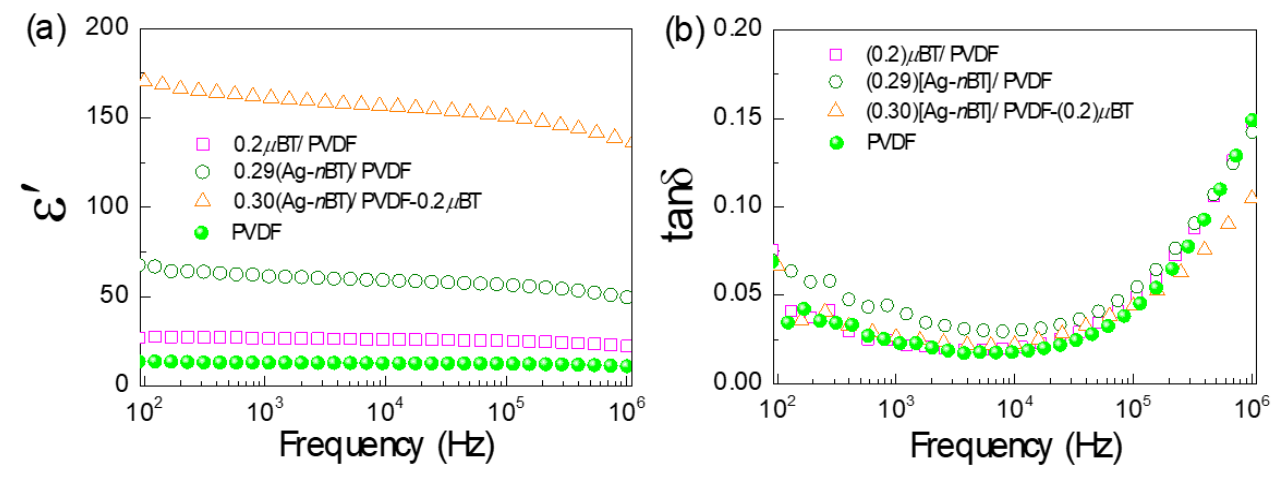
Figure 6. Comparison of ( a ) ε′ and ( b ) tanδ at RT for PVDF polymer, (0.2) μ BT/PVDF, (0.29)[Ag- n BT]/PVDF, and (0.30)Ag- n BT/PVDF-(0.2) μ BT composites.